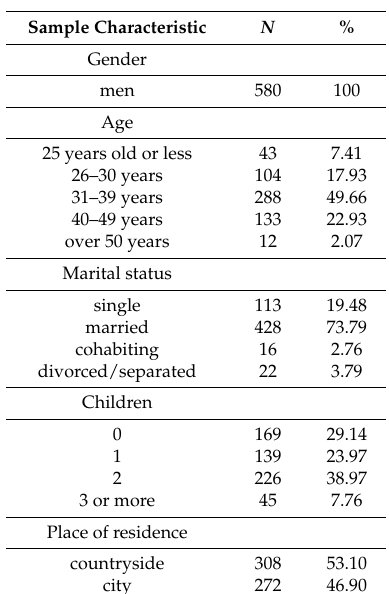
Table 1. Sociodemographic characteristics of the sample ( N = 580).